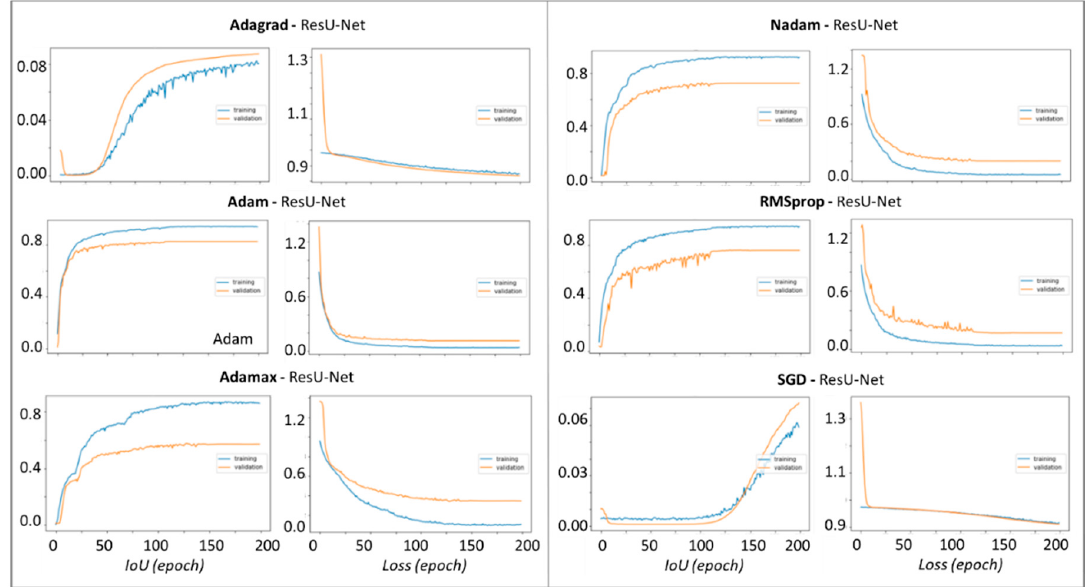
Figure 5. The input mask generated based on visual interpretation, combined with field interpretation samples using standard GCPs.